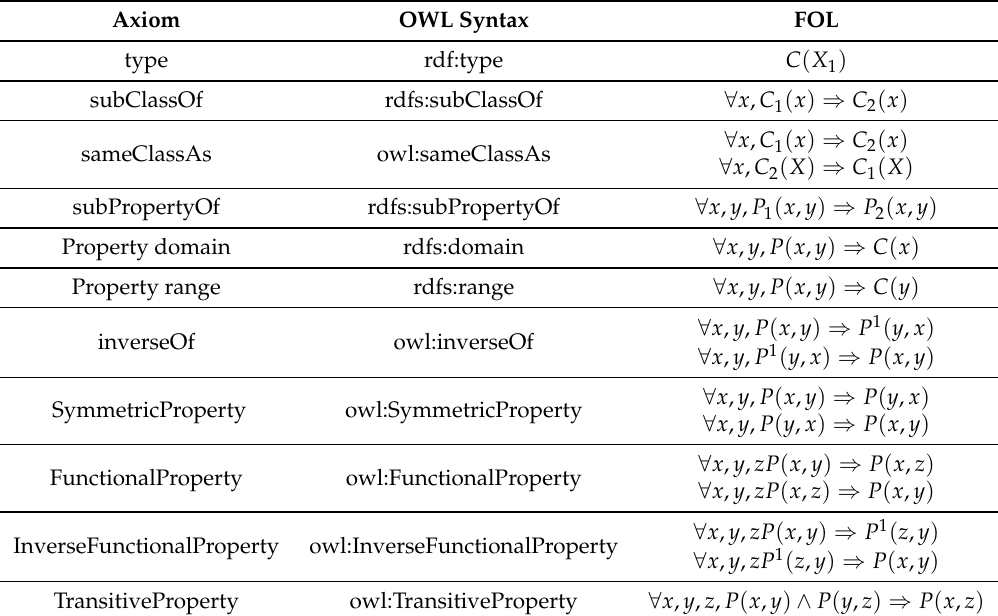
Table 2. Translation of OWL axioms to